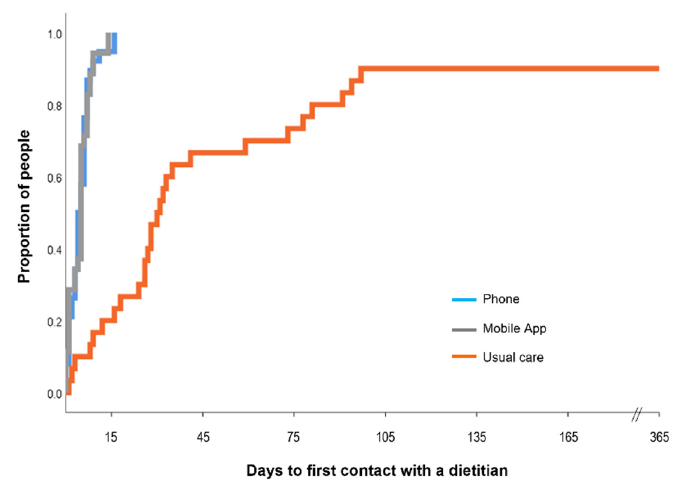
Figure 2. Time from randomisation to first contact with a dietitian. The first contact with a dietitian was significantly delayed in the usual care group compared with the intervention groups (telephone mean (SD) 5 (4) days, range 0–16 days n = 38; mobile app 5 (4) days, range 0–14 days, n = 33 noting that three participants withdrew prior to first contact) compared with the control group (70 (104) days, range 1–365 days, n = 30; n = 7 reported no data about contact with a dietitian). Data were censored at the end of the follow up period of 365 days. Table 2. Frequency of contact with a dietitian as part of usual care *.